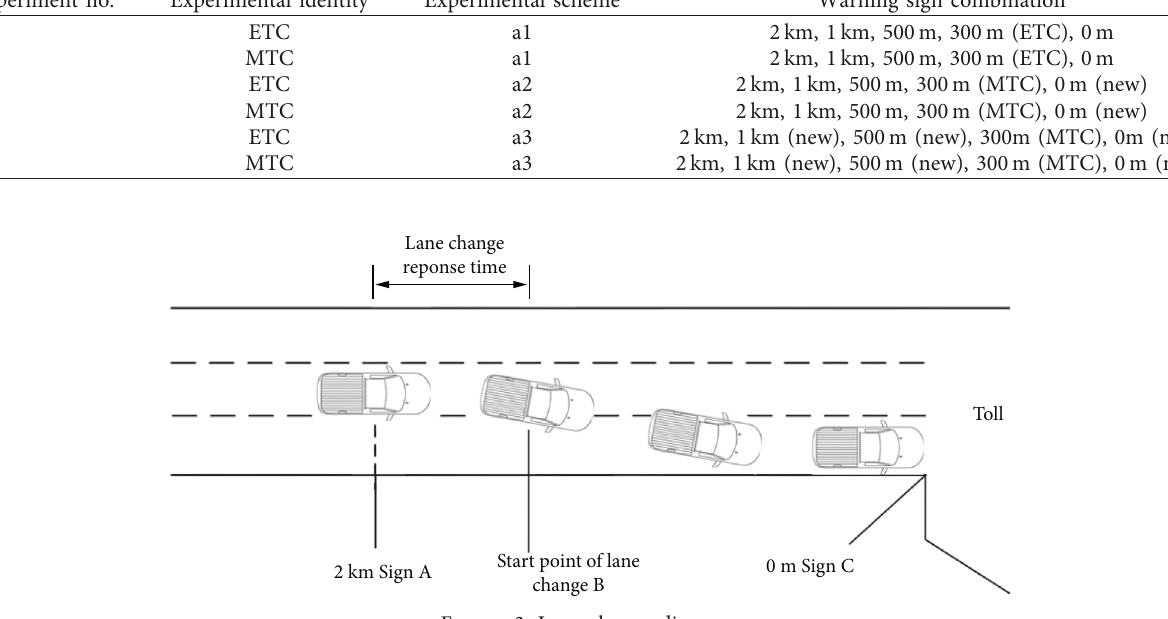
Figure 3: Lane change diagram. Table 3: Results of descriptive statistical analysis of response time and analysis of variance